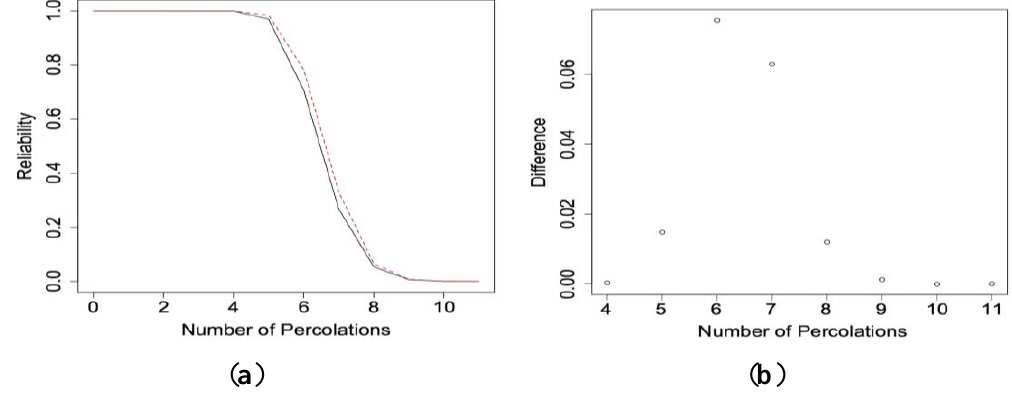
Figure 9. ( a ) R ( x ) calculated using our algorithm when the electrical current can 20 × 20 move in all directions (top curve) and when movement is restricted (bottom curve) when p = 0.90 and ( b ) the difference between the R ( x ) 20 × 20